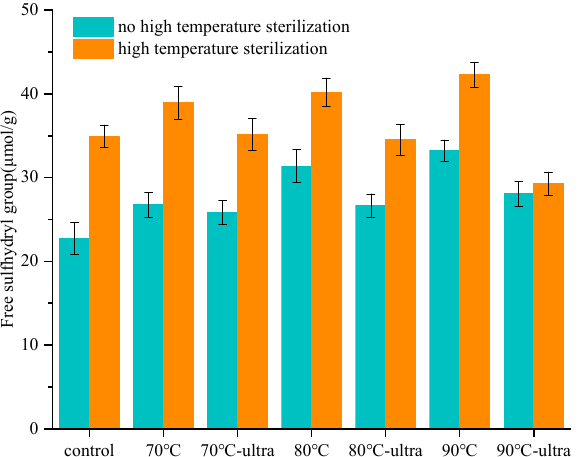
Figure 3. SH of different coconut globulin samples (ultra: 53 kHz, 40 w / l ; 70, 80 and 90 °C represent preheating for 20 min; high ‐ temperature sterilization: 135 °C for 60 s). Different letters indicate sig ‐ nificant differences at p < 0.05.